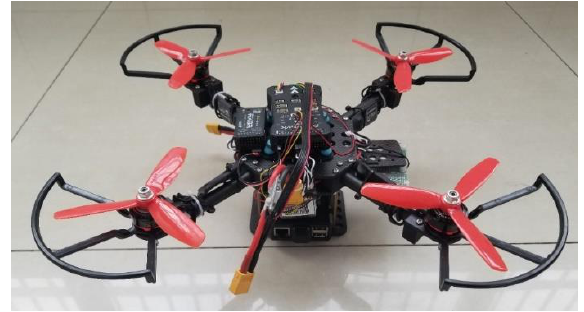
Figure 6. Indoor aircraft platform.